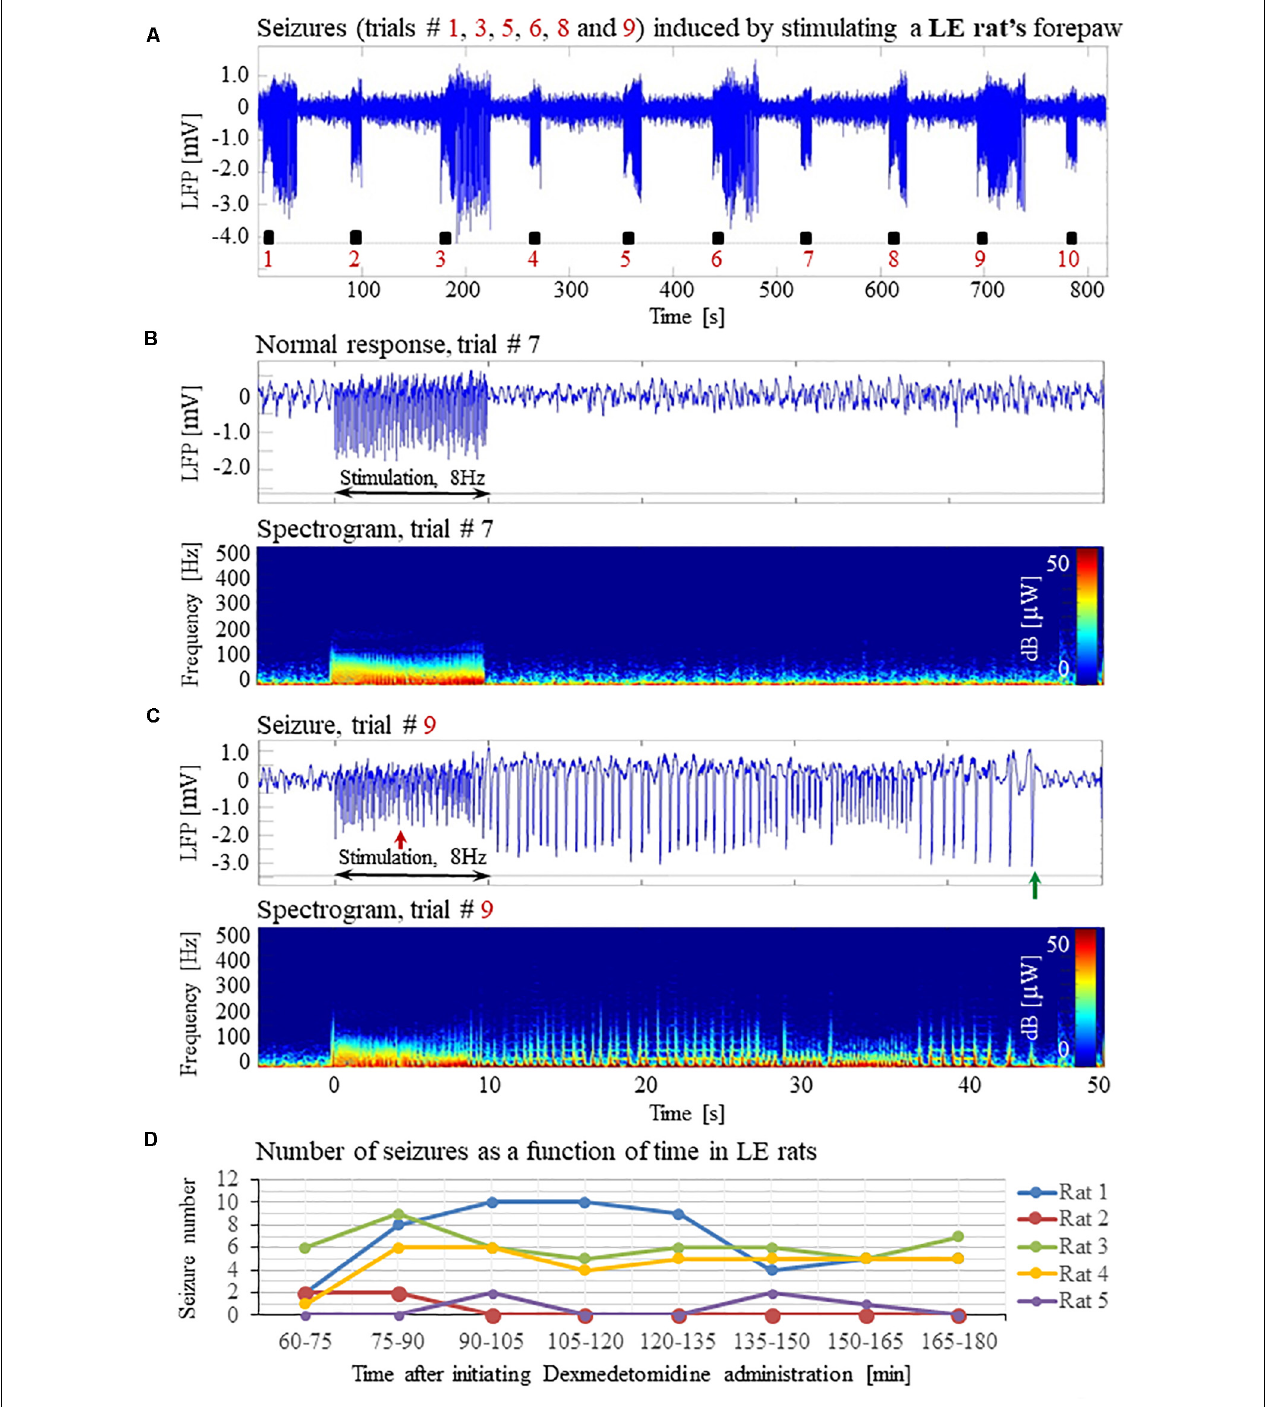
FIGURE 11 | Forepaw stimulation induces epileptic activity in LE rat. (A) LFP recordings of ten trials, each with 10 s-long stimulation. The stimulation periods are marked by black rectangles. Note that during the first, third, fifth, sixth, eighth, and ninth trials, the stimulation induced a seizure. (B) Top: The LFP (mean averaged over electrode contacts spanning the cortical depth) demonstrates a normal-evoked response in trial #7. Bottom: The corresponding spectrogram (power as a function of frequency and time) computed for the same trial. (C) Top: LFP (mean averaged over electrode contacts spanning the cortical depth) showing a seizure pattern in trial #9. The red and green arrows indicate the onset and termination, respectively, of a seizure induced by forepaw stimulation. Bottom: The corresponding spectrogram, computed for the same seizure. (D) The number of evoked seizures per rat as a function of time shows that seizures are induced already during the first or the third run, only one hour after initiating the dexmedetomidine